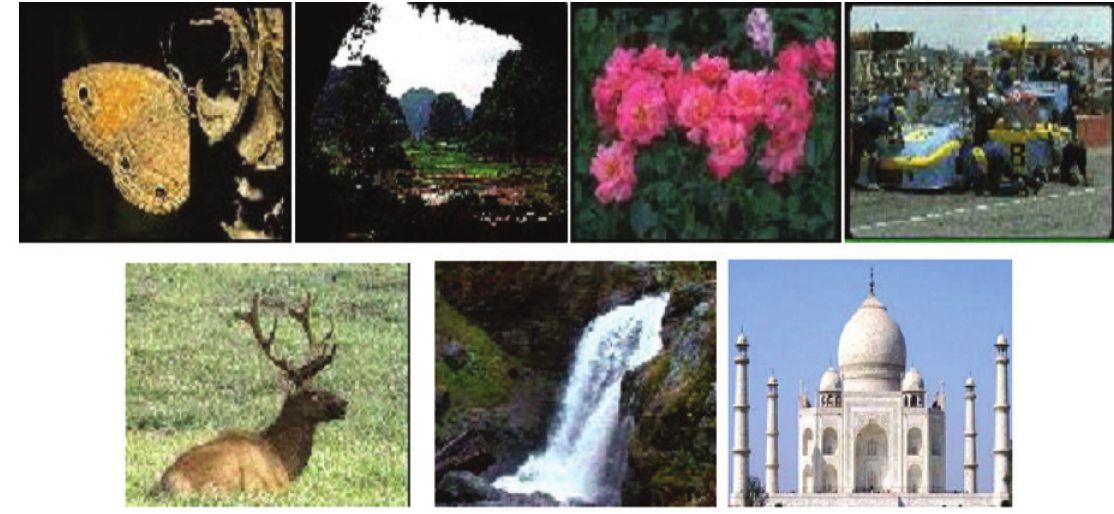
Figure 4: Experimentally Used Sample